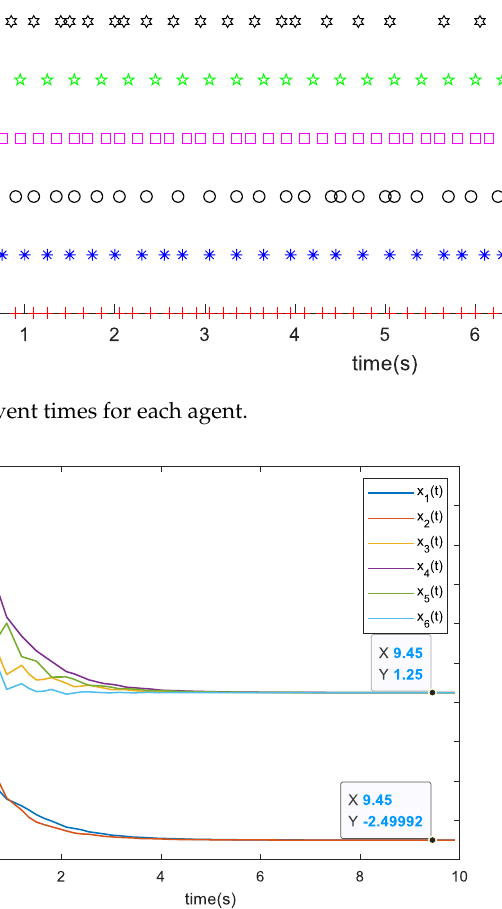
Figure 6. The states of agents.